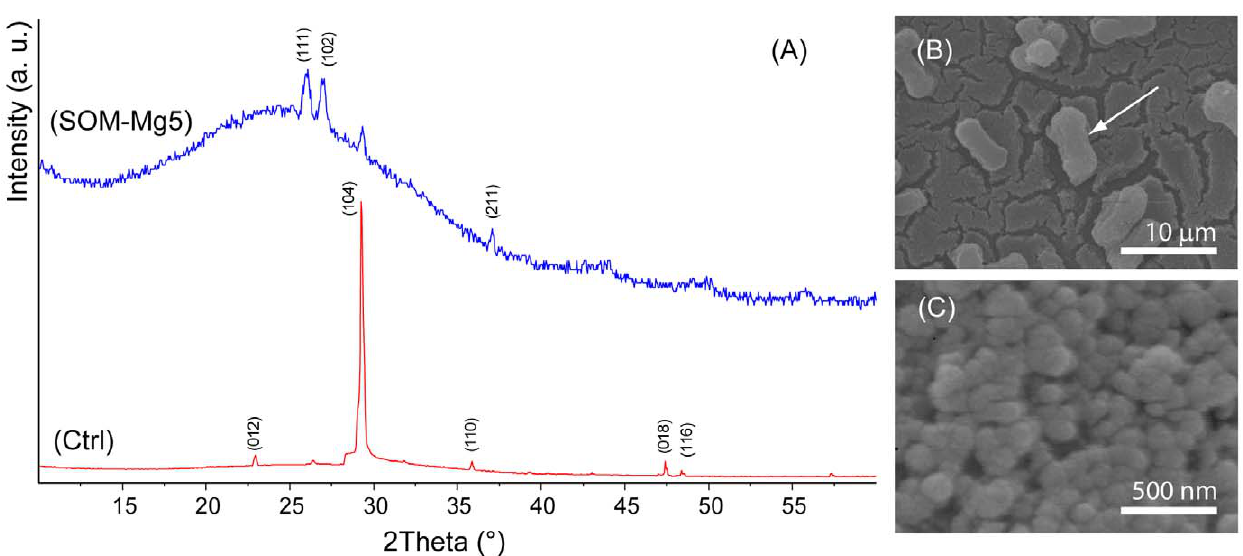
Figure 8. Calcium carbonate crystallization experiments. (A) X-ray powder diffraction patterns of the precipitates obtained from a 10 mM calcium chloride solution (Ctrl), from a 10 mM calcium chloride solution containing SOM and magnesium ions in Mg/Ca molar ratio equal to 5 (SOM- Mg5). In (Ctrl) only calcite is present, while in (SOM-Mg5) a mixture of calcite and aragonite is present. Moreover, in (SOM-Mg5) the broad band around between 20 u and 40 u suggests the presence of amorphous material. The calcite diffraction peaks, (012), (104), (110), (018) and (116), were indexed according to the reference pattern PDF 98-000-5342 [61], while the aragonite diffraction peaks, (111), (102) and (211), were indexed according to the reference pattern PDF 98-006-0908 [60]. (B and C) SEM pictures of the precipitate obtained from SOM-Mg5. Crystals of magnesium calcite (see arrow in (A)) and aragonite deposited on, and into, a jagged layer of ACC. In (B) is shown a magnification of the ACC layer, in it small particles of about 100 nm in diameter are visible.